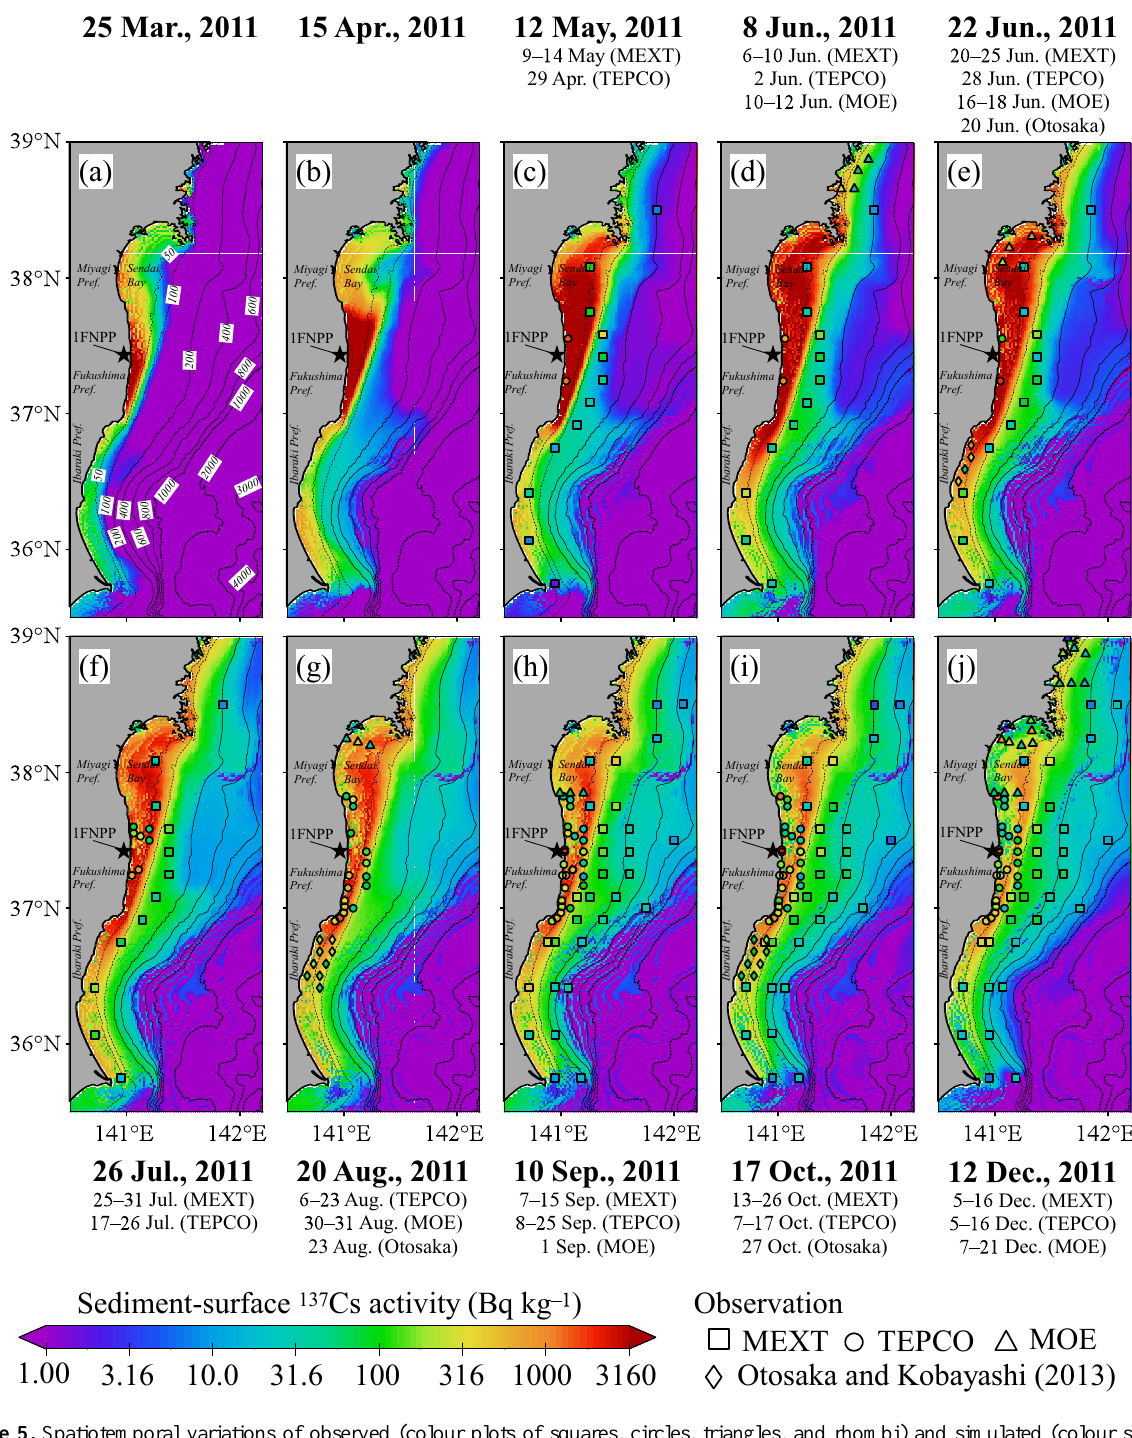
Figure 5. Spatiotemporal variations of observed (colour plots of squares, circles, triangles, and rhombi) and simulated (colour shading) sediment-surface 137 Cs. Dates of simulated/observed results are denoted by bold/normal characters. Observed activities of MEXT (2011) (squares), TEPCO (2011) (circles), Otosaka and Kato (2013) (triangles), and Ministry of the Environment (MOE, 2011) (rhombi) are indi- cated using same colour table as the simulated result. Black star indicates location of 1FNPP. Contours show water depth (m) according to JTOPO30 (MIRC). Units of TEPCO observations are Bqkg − 1 -wet, whereas those of the others including the simulation are Bqkg − 1